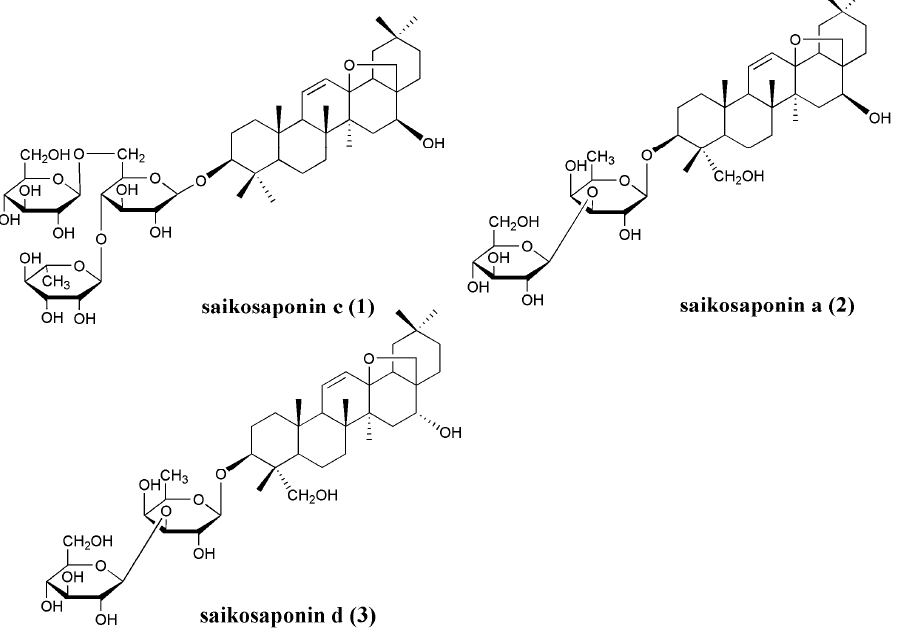
Figure 1. Chemical structures of three major saikosaponins from the roots of B. falcatum